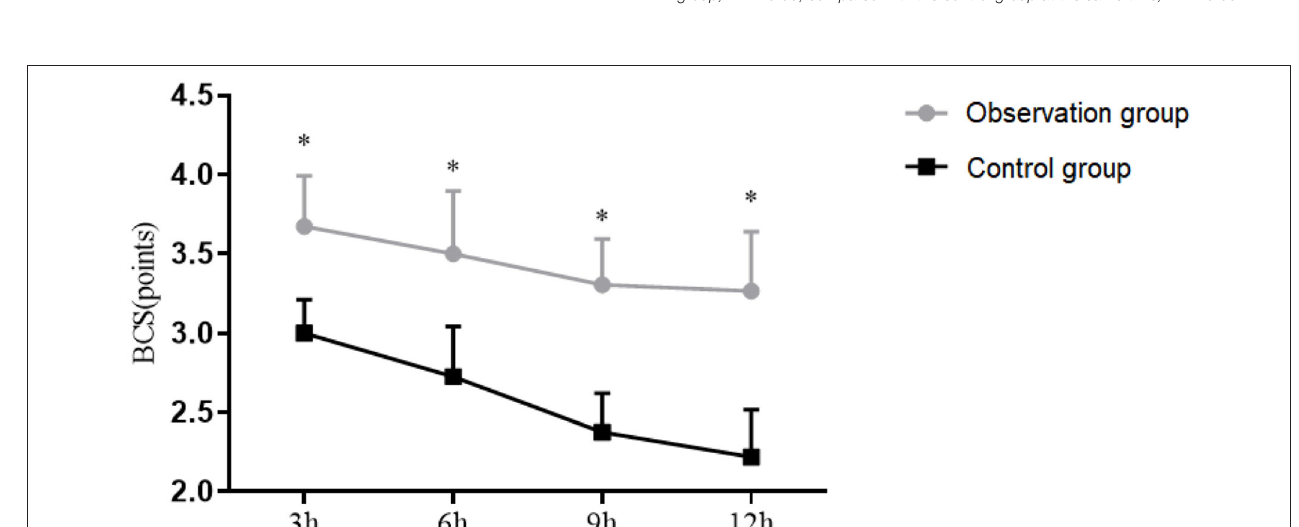
FIGURE 2 | Bruggemann comfort scale (BCS) of patients. The transverse axis was time after surgery (3, 6, 9, and 12h), and the vertical axis was BCS. * P < 0.05.